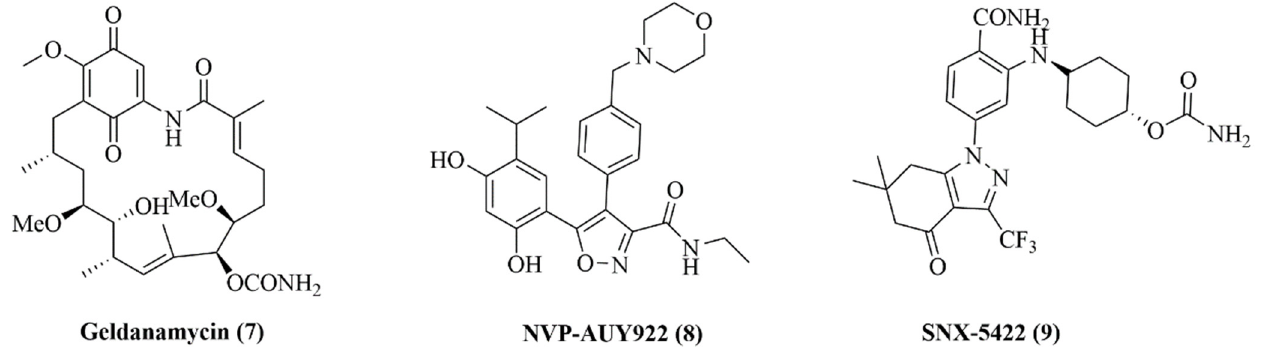
Figure 10. Reported representative Hsp90 inhibitors.